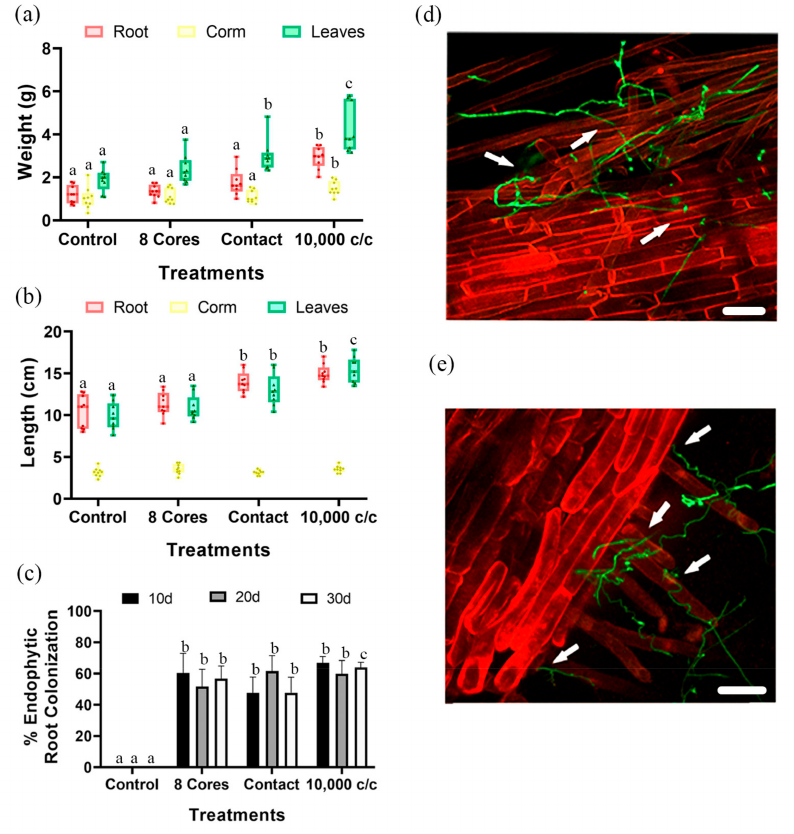
Figure 1. Effect of P. chlamydosporia 123 on banana plantlets. Treatments: eight cores from the edge of 21-day-old P. chlamydosporia (Pc) colony; contact of banana plantlet in Magenta Box with Pc for 5 days; 10,000 c / c spore suspension of Pc; control, uninoculated plantlets. ( a ) Maximum root, corm, and leaf weight. ( b ) Fresh root, corm, and leaf length. ( c ) Endophytic root colonization by Pc123. In the parameters analyzed individually, treatments with different letters indicate significant differences ( p -value < α = 0.05), treatments without letters indicate there are no significant differences. ( d ) Root hairs colonization; ( e ) rhizoplane colonization of Musa acuminata by Pc123 GFP modified strain. Arrows: indicate possible hyphal penetration points in the root. White bar = 75 µ